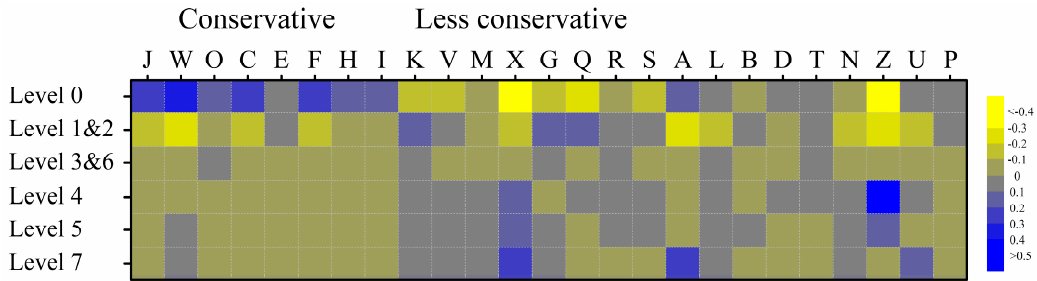
Figure 3. The frequency of the orthologs at different conservation level broken down by COG category.